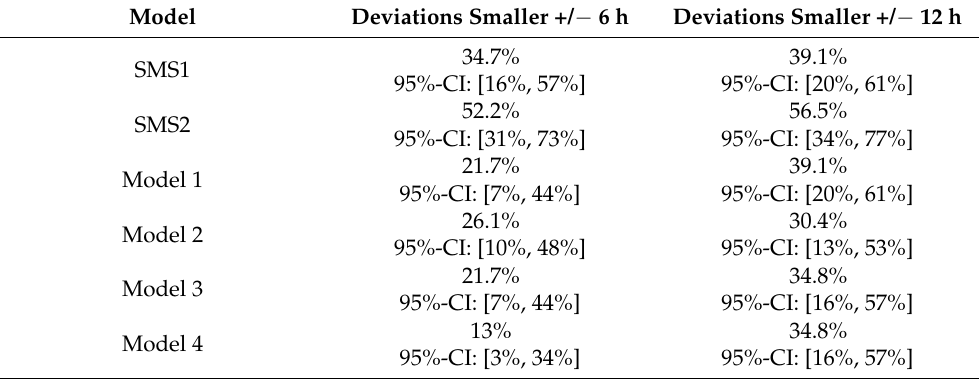
Table 3. Percentages of deviations between model predicted birth times and true birth times in